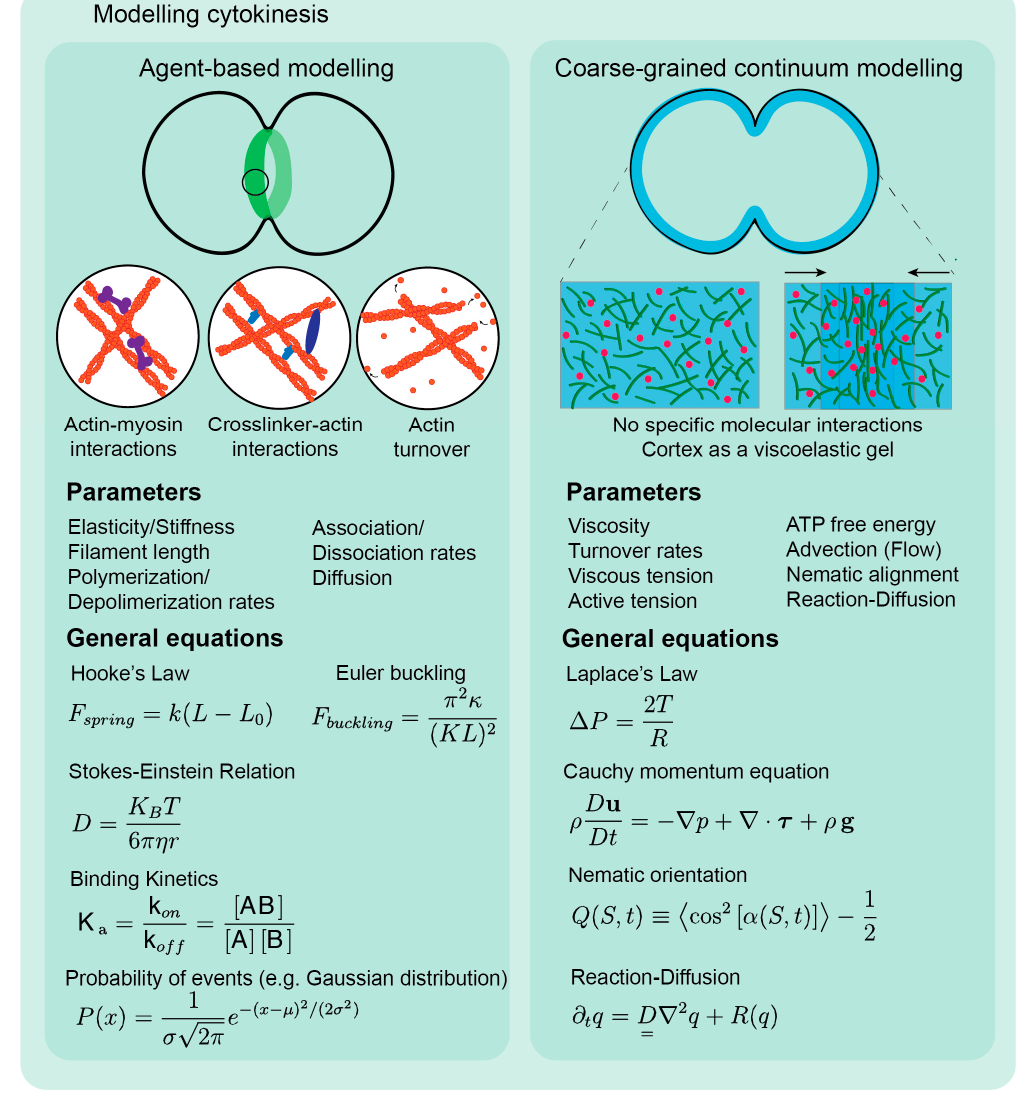
Figure 3. Modeling of cytokinesis is generally subdivided into two distinct approaches: agent-based simulations and coarse-grained continuum models. Agent-based models focus mostly on the CR alone and specific interactions and dynamics between cortex components are considered (myosin-actin and actin-crosslinkers interactions, as well as actin turnover dynamics). Coarse-grained models provide a description of the entire cell surface, where the cortex is seen as a viscoelastic gel able to contract in response to stress arising from physico-chemical gradients. All definitions of biochemical and mechanical parameters mentioned can be found in the Glossary, as well as their application on specific types of models of the cell cortex. The equations were chosen to convey a simplified and generalized idea of the approaches that can be used on each type of model, and therefore, may lack higher-order detail used on most mathematical models.